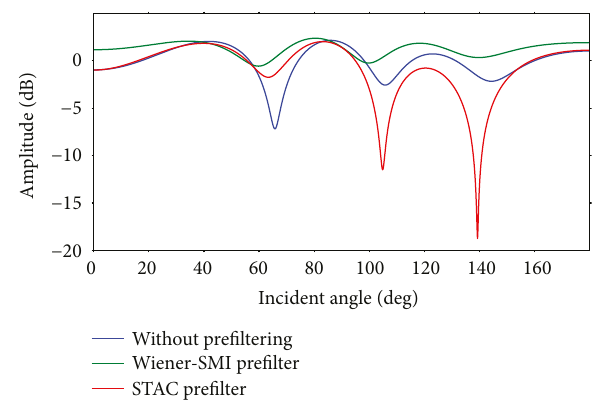
Figure 13: Calulated beampatterns from the mesured data with di ff erent pre fi ltering